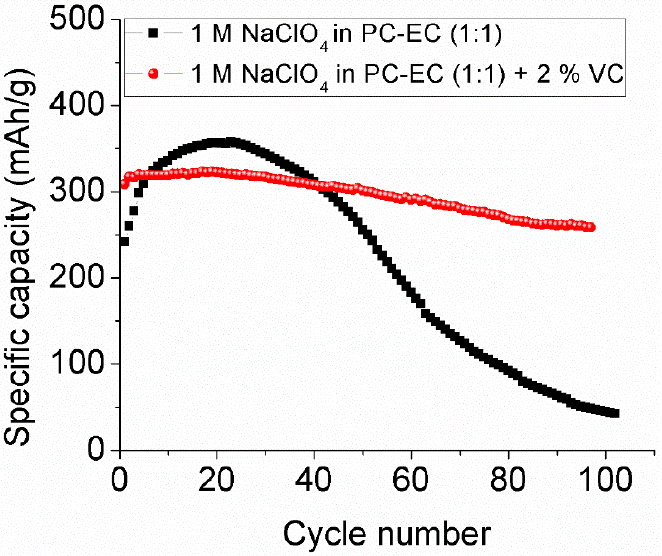
Figure 6. Change in the discharge capacity of Ge in without-VC and with-VC electrolyte solutions at 125 mA/g.